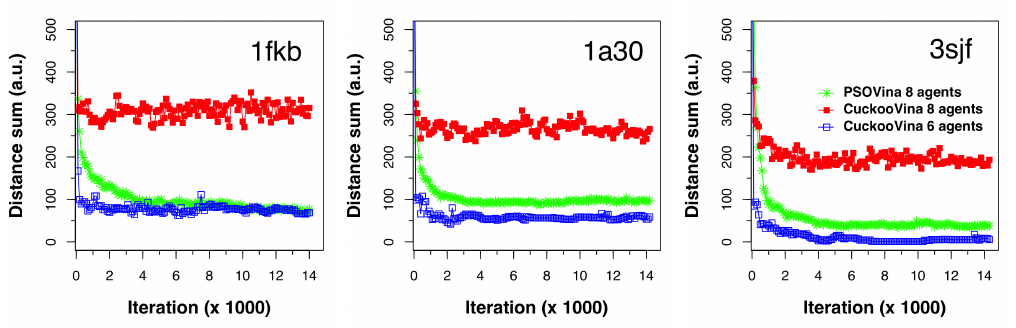
Figure 3. Search space coverage measured as the sum of pairwise distances between search agents in the docking process of the 1fkb, 1a30, and 3sjf